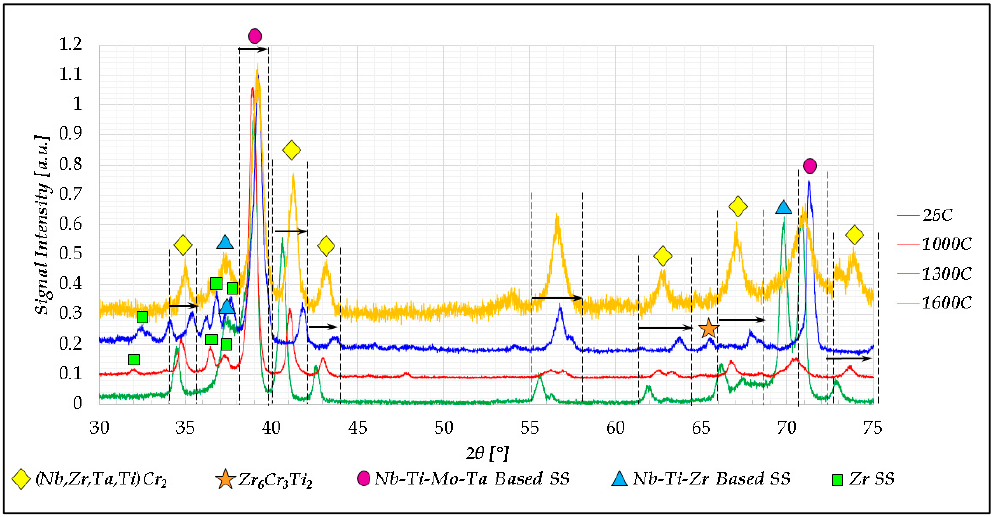
Figure 8. XRD traces of the Cr 20 Mo 10 Nb 20 Ta 10 Ti 20 Zr 20 alloy at 25 °C, 1000 °C, 1300 °C, and 1600 °C; the shifts in 2 θ values of certain peaks as a result of the rising temperature are marked in arrows.